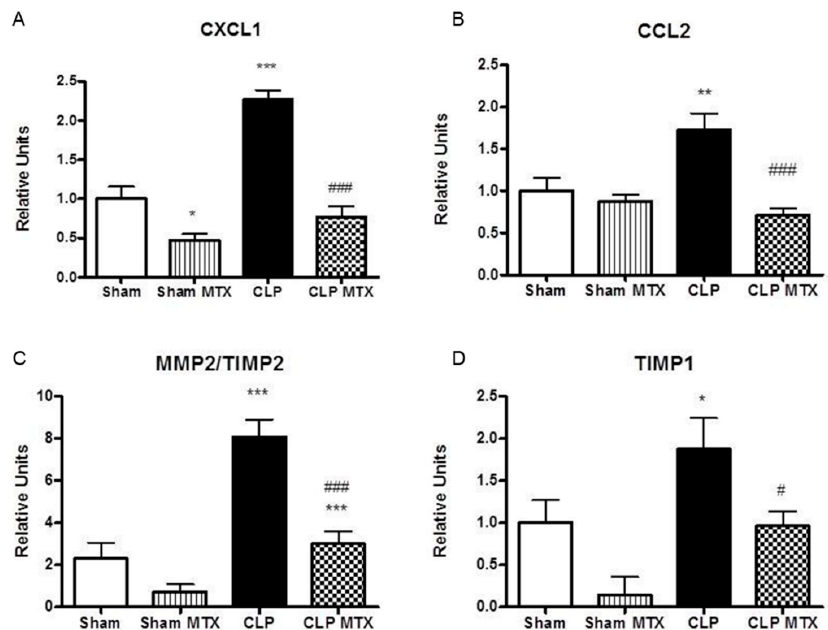
Figure 6. Gene expression of cell recruitment markers and metalloproteinases and its inhibitors in lung tissue. ( A – D ): mRNA expression by qPCR. Data are expressed mean ± SEM, ∆ Ct correction was applied using GAPDH as a housekeeping gene and units are relative to the expression of control group. Sham and Sham + MTX n = 10; CLP and CLP + MTX n = 15. * p < 0.05 vs. Sham group; # p < 0.05 vs. CLP group. ** p < 0.01; ***/### p <